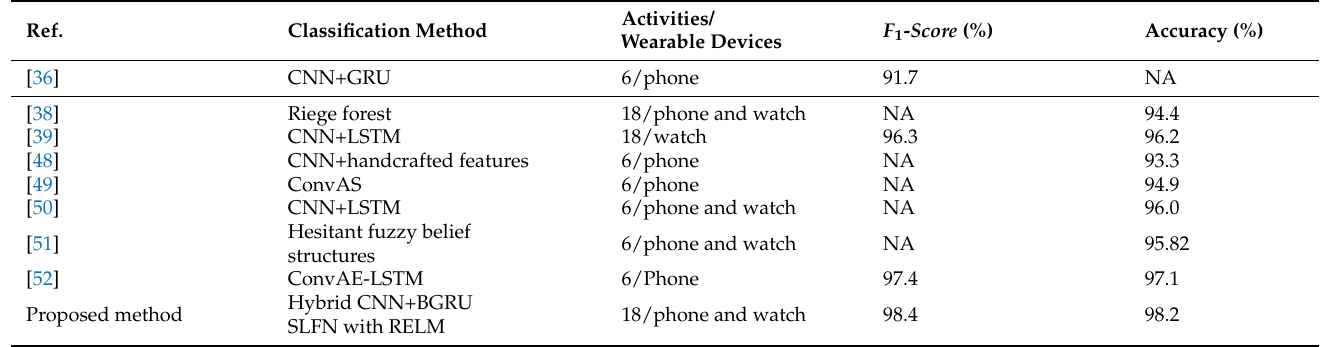
Table 9. Comparative results of various methods using the UCI-WISDM dataset. Ref.